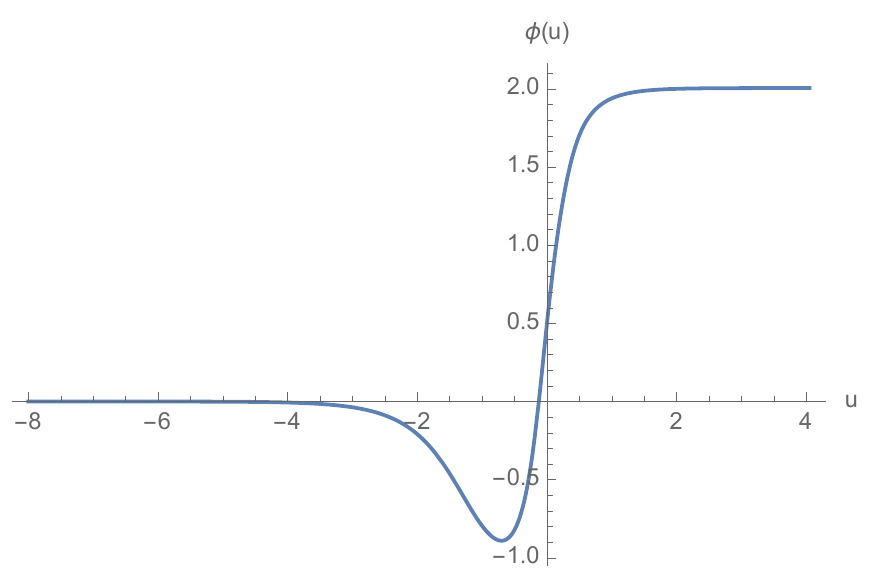
Figure 19 . Bouncing zero-temperature solution for the potential shown in (cid:12)gure 18.